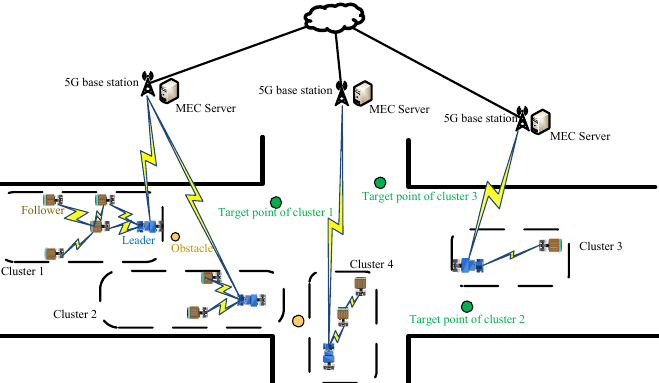
Figure 1. The structure of the industrial park. The scenario is divided into three layers: the cloud layer, the edge layer, and the device layer. The cloud layer is mainly responsible for assigning tasks and setting target points. The AGVs in the device layer are connected adaptively by Wi-Fi. They are grouped and travel to the target point to complete the transport task, during which they need to avoid obstacles. The leader of each cluster is connected to the edge layer device using